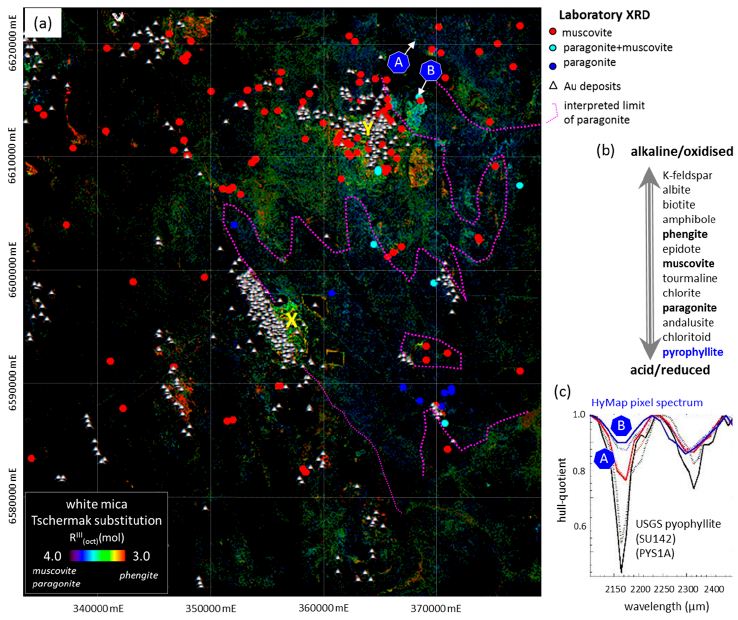
Figure 11. Alteration mineralogy of the Kalgoorlie region, Western Australia, spanning a 50 × 50 km area (25 airborne HyMap™ flight-lines @ 5 m pixel resolution) centered over Kalgoorlie city. ( a ) Airborne HyMap™ (~2005) derived image of white mica composition based on the wavelength minimum (first derivative of a fitted fourth-order polynomial) of the continuum-removed 2200 nm absorption between 2120 and 2250 nm and masked to only include pixels with a detectable 2200 nm absorption. X marks the Superpit and Y is Kanowna Belle gold mines; ( b ) Predicted mineral suite with changing pH and REDOX [104] at greenschist facies. Note prediction paragonite and pyrophyllite in more acid/reduced conditions; ( c ) Selected HyMap™ pixel spectra and USGS library spectra showing the diagnostic major absorption feature at 2160 nm and minor one at 2320 nm for pyrophyllite.